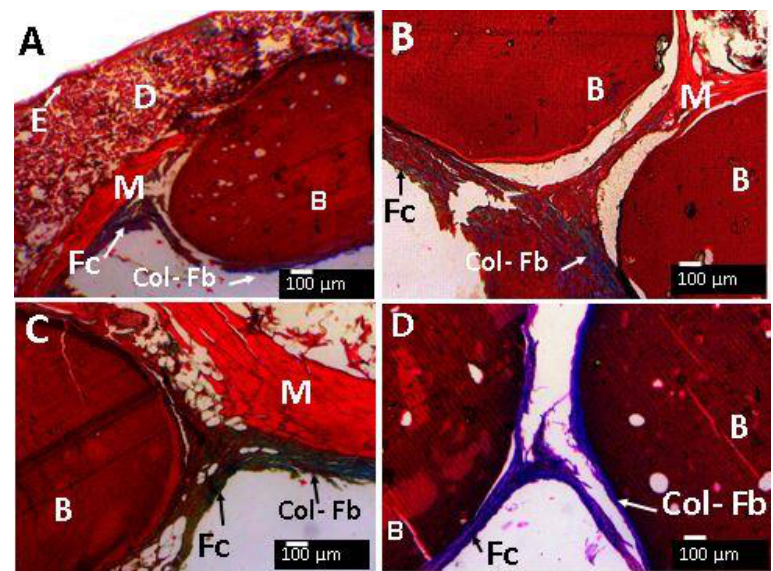
Figure 12. Beads implanted in subdermal tissue. ( A ) CS-GO-GLA. ( B ) CS-TiO 2 - GLA. ( C ) CS-GO-GLA. ( D ) CS-GO-TiO 2 -GLA. ( A ) at 4×. ( B ), ( C ), and ( D ) at 10×. E: Epidermis. D: Dermis. M: Muscle. B: Bead. Fc: Fibrous capsule. COL - Fb: Type I collagen fiber. Masson′s trichrome stain (MT) technique. Molecules 2020 , 25 , x FOR PEER REVIEW